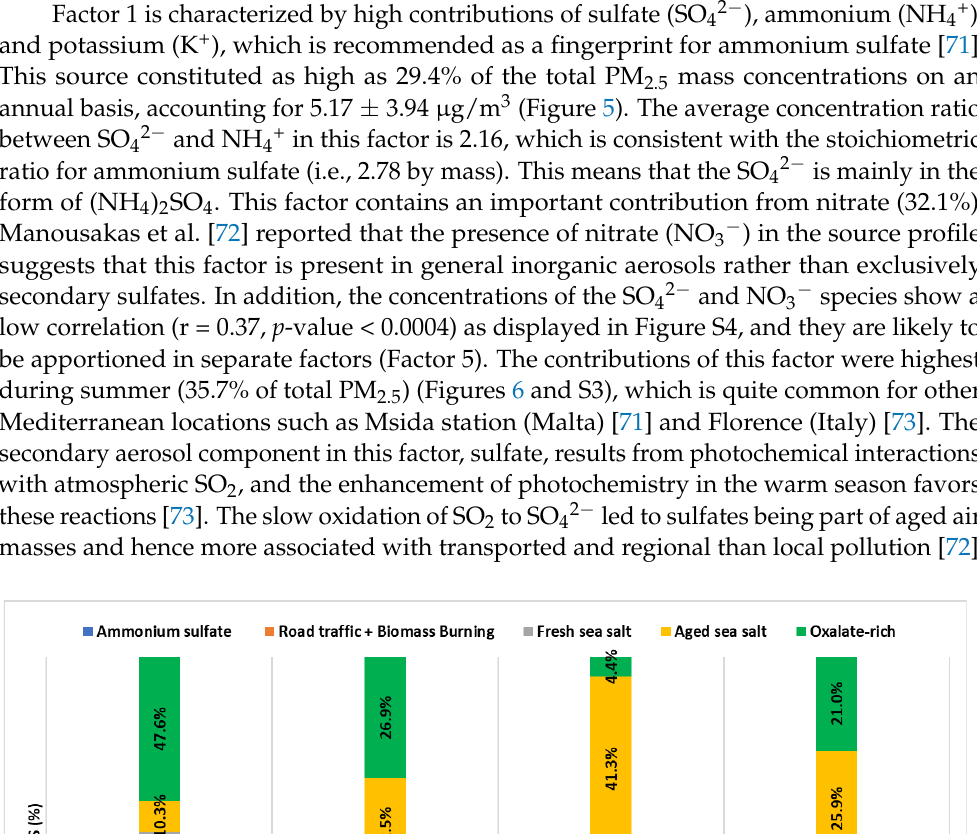
Figure 5. Percentage contribution of the different PMF-resolved factors to the modeled PM 2.5 con- centrations.